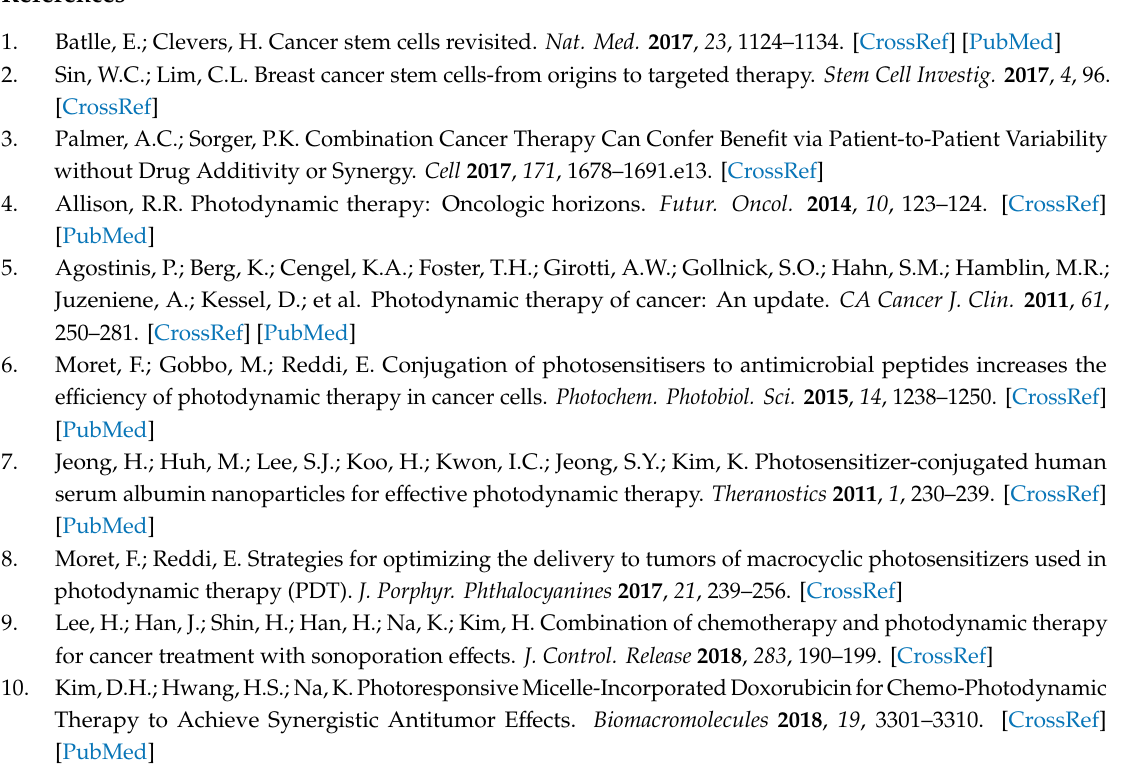
Figure S1: Release of TPCS 2a and DTX from HA@DTX / TPCS 2a -NPs; Figure S2: Cytotoxicity of free drugs